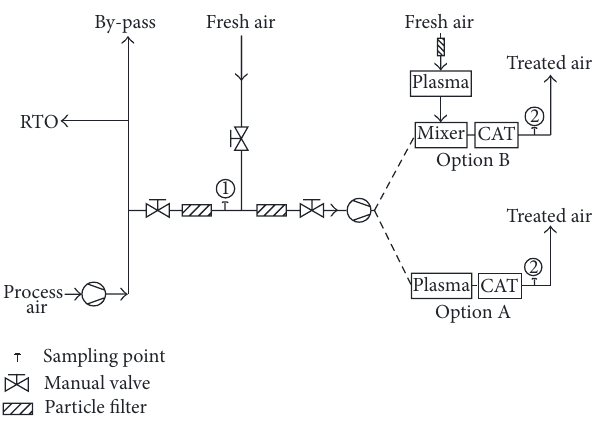
Figure 1: Diagram of flow process of the NTP-CAT pilot plant configurations